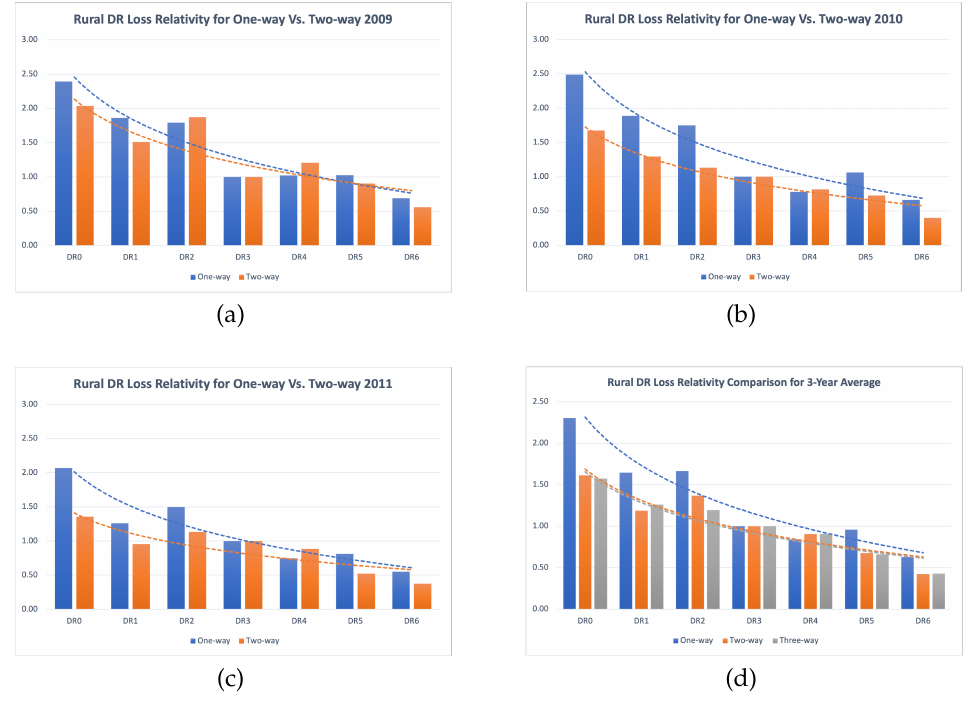
Figure 5. Comparison of DR relativity based on “Rural” loss data, estimated by different models including one-way, two-way and three-way models. ( a – c ) present the comparison between one-way and two-way analysis, respectively for year 2009, 2010 and 2011. ( d ) shows the comparisons of one way, two-way and three-way for three years average